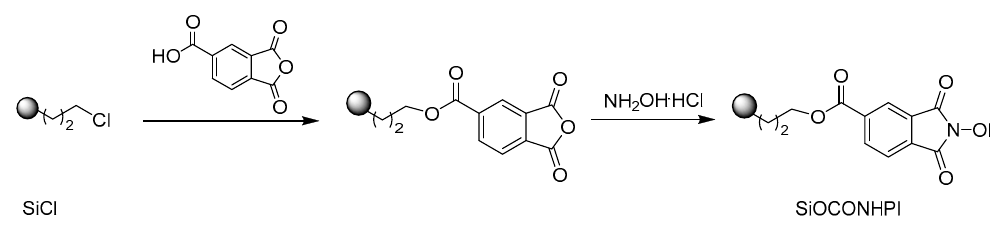
Figure 3. Synthesis of NHPI immobilized on chloropropyl silica gel via ester